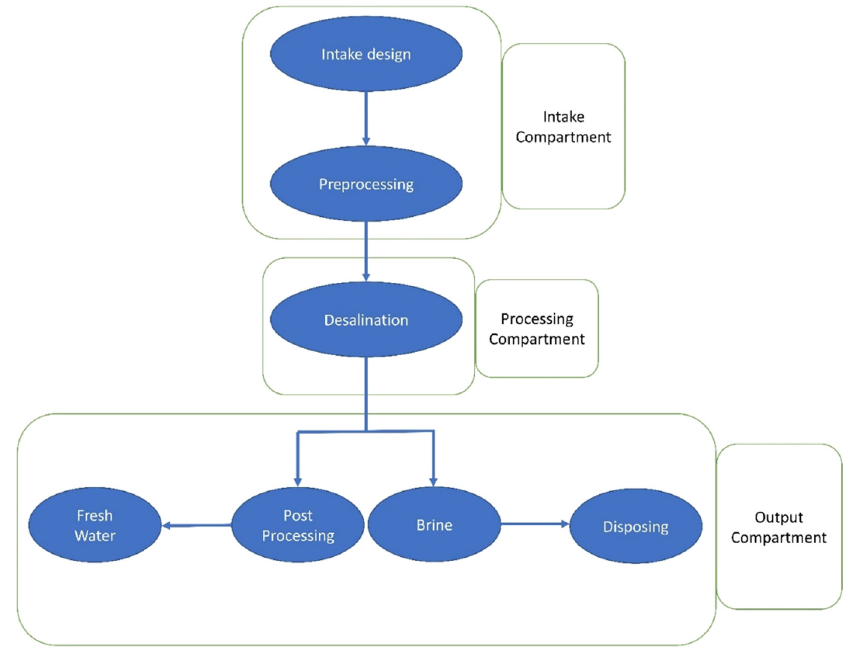
Figure 1: General principle of the desalination